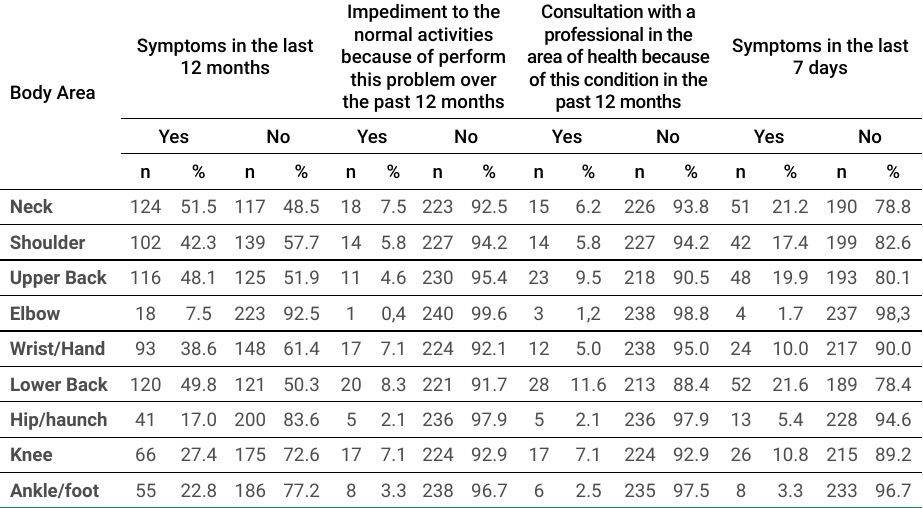
Table 3. Associations between body regions and musculoskeletal symptoms according to the dimensions of the Nordic Musculoskeletal Questionnaire. Impediment to the Consultation with a normal activities professional in the Symptoms in the last Symptoms in the last because of perform area of health because 12 months 7 this problem over of this condition in the Body Area the past 12 months past 12 months